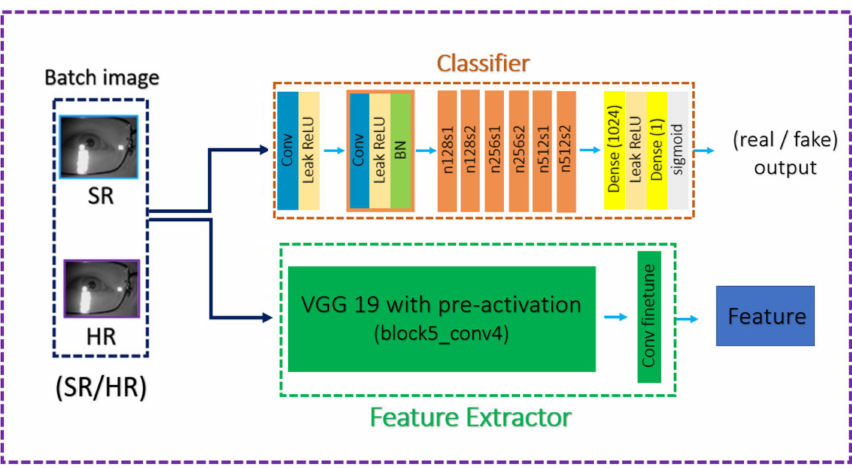
Figure 7. The network structure of the discriminator in